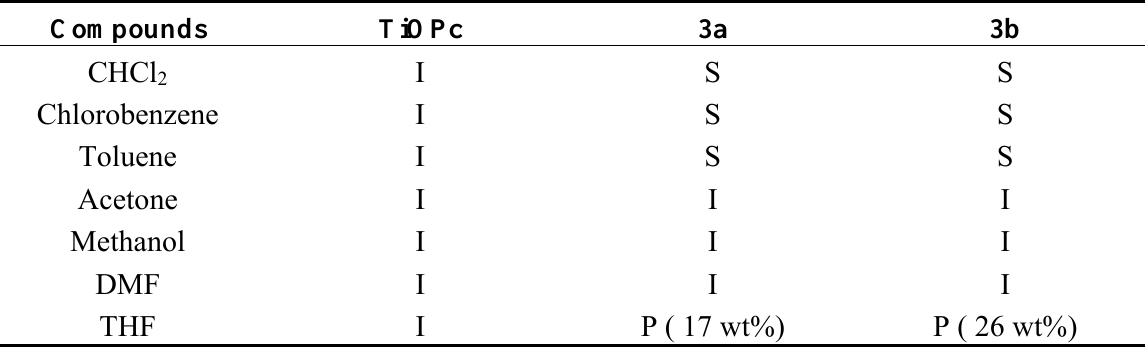
Table 1. Solubility of TiOPc, 3a , and